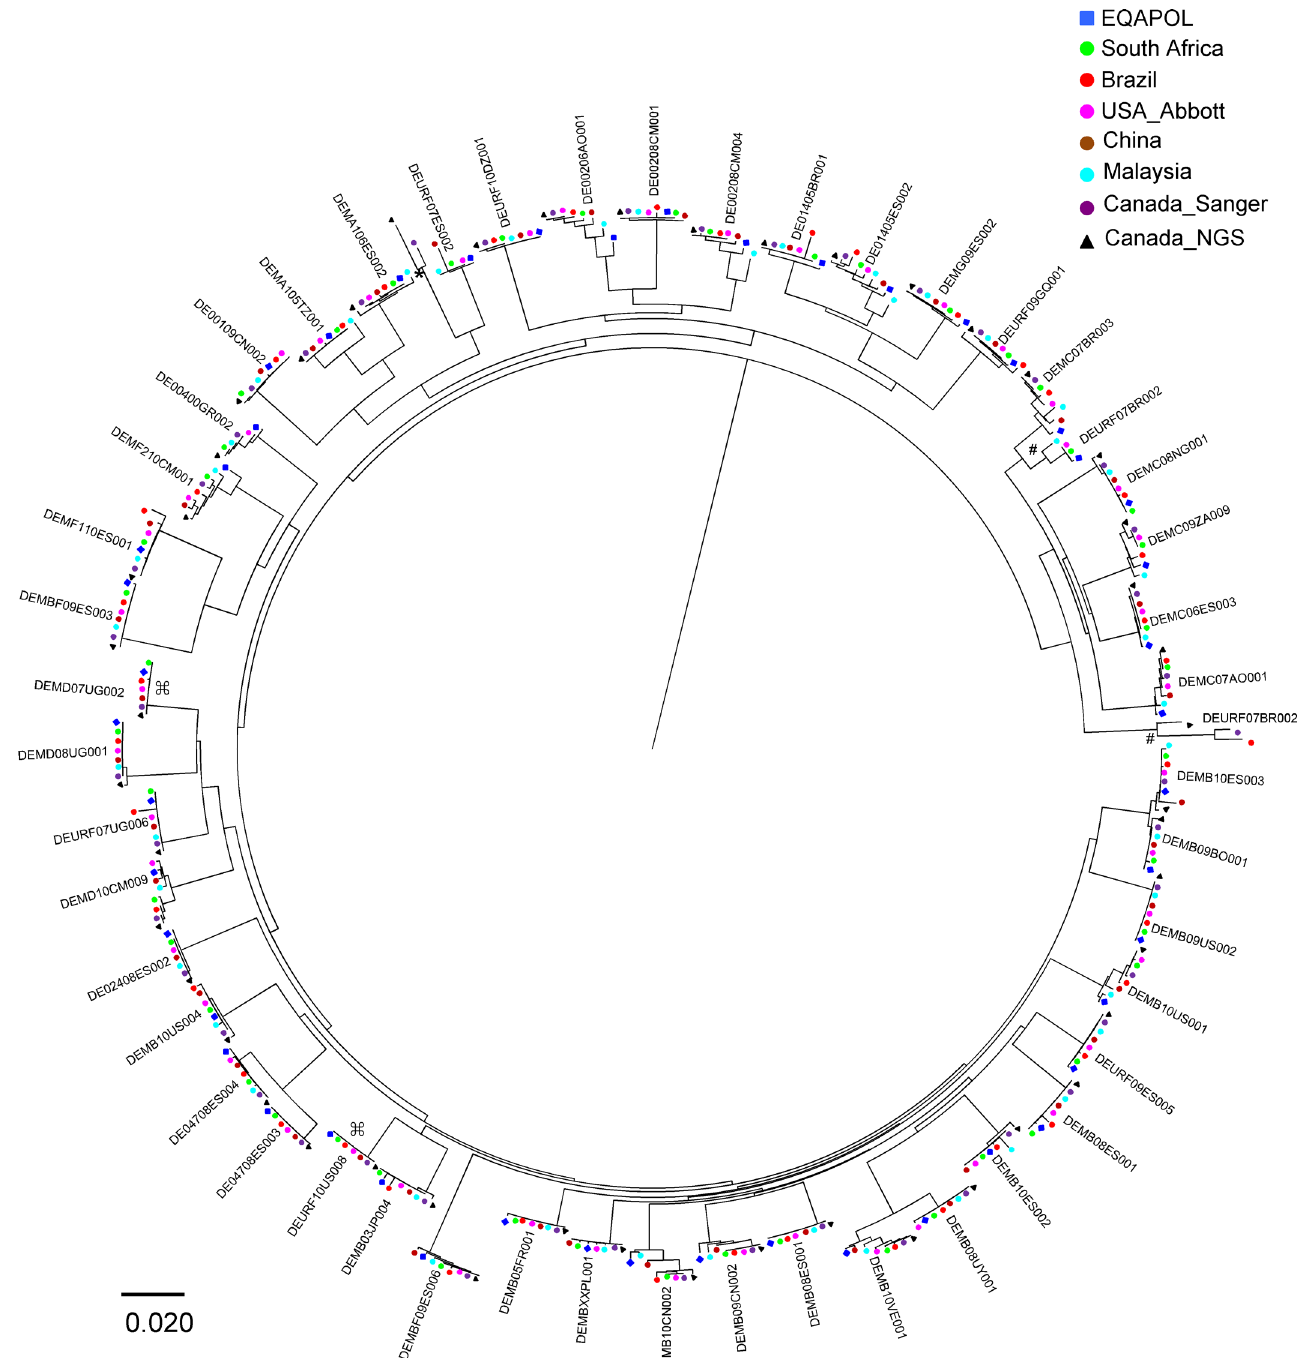
Fig 5. Phylogenetic analysis of partial pol gene sequences from all sites. All group M virus sequences (47) from six sites were analyzed together with the EQAPOL reference sequences. The phylogenetic tree was constructed using the neighbor-joining (NJ) method with Kimura two- parameter model. Sequences from the USA_FDA site were not included due to divergent sequence fragments. Ambiguous bases in DEURF07ES002 ( * ) and DEURF07BR002 (#) from Canada and Brazil sites resulted in independent branches. The short sequences ( ⌘ ) of DEMD07UG002 and DEURF10US008 from the Malaysia site were excluded from the analysis.